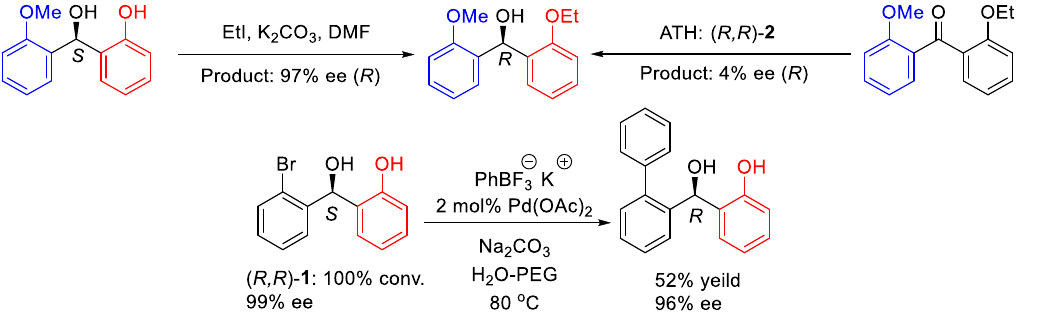
Figure 15. Functionalizations of the ATH products.